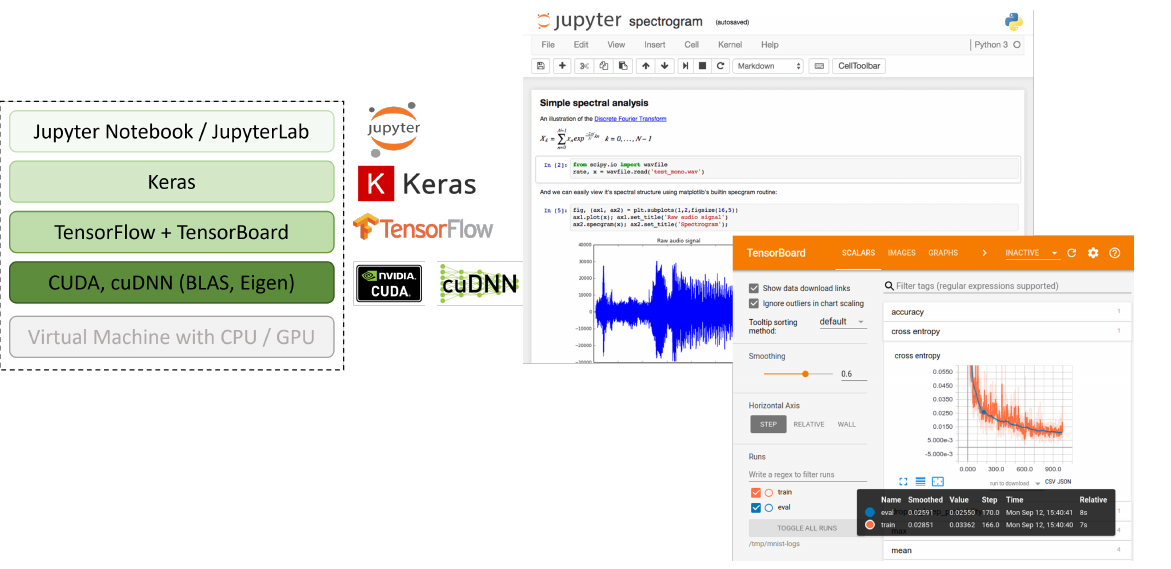
Figure 2. Example of a Software Architecture Fragment (SAF): Data exploration using Jupyter- Lab/Jupyter